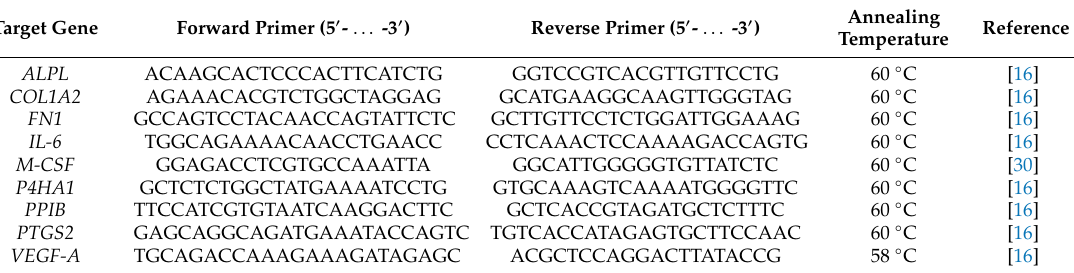
Table 1. Primers used for